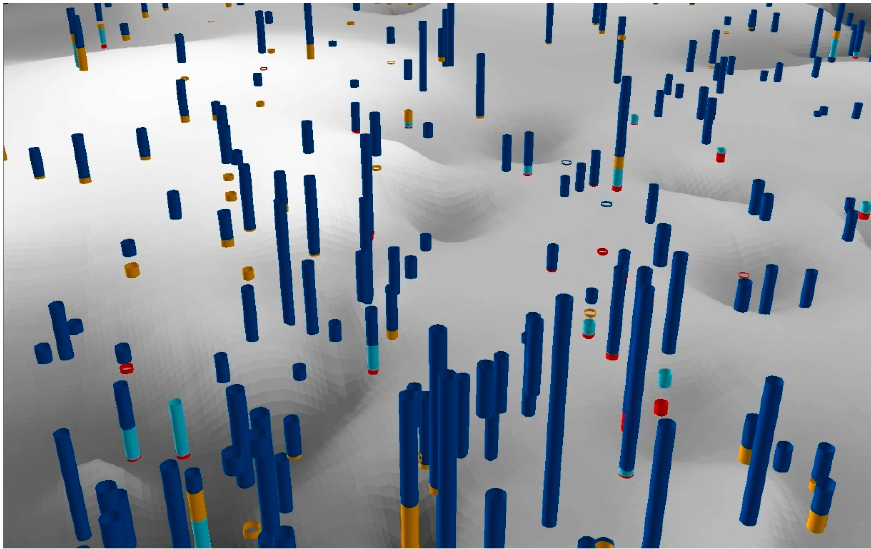
Figure 4. Perspective view of a sample of stratigraphic picks. The gray background represents the bedrock surface; light gray represents bedrock highs, dark gray represents bedrock lows. Dark blue represents stratigraphic picks for the Tiskilwa Formation, orange represents Sub-Tiskilwa picks, light blue represents Winnebago Formation picks, and red represents Sub-Winnebago Formation picks.